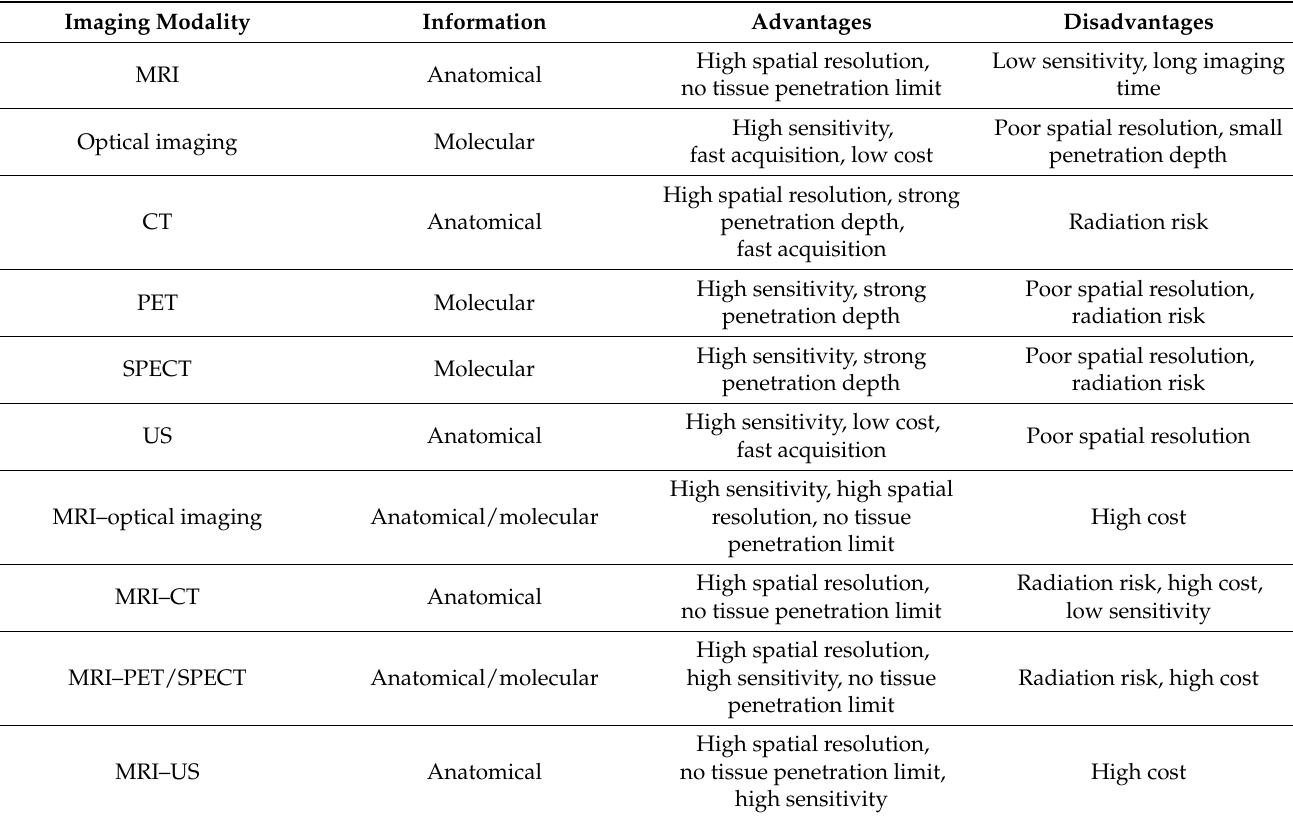
Table 1. Pros and cons of individual and combined imaging modalities used in molecular imaging and discussed within this review. Imaging